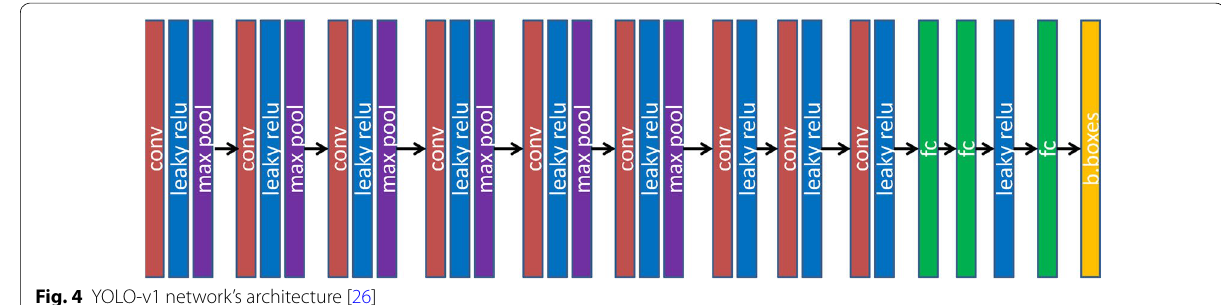
Fig. 4 YOLO‑v1 network’s architecture [26]